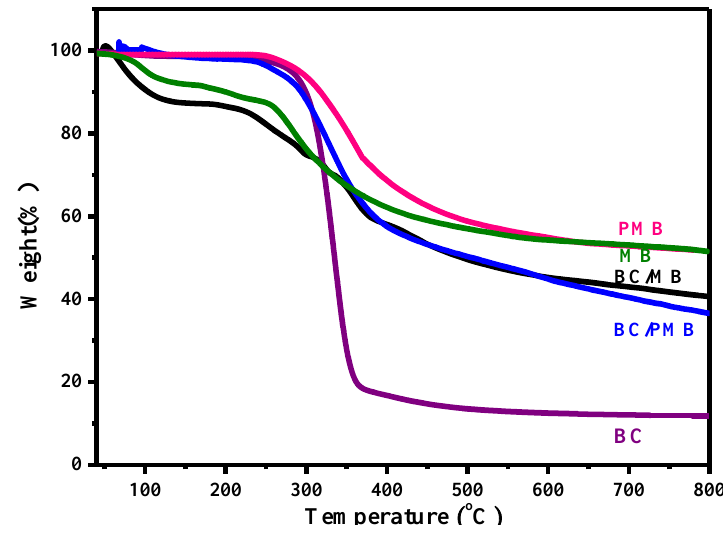
Figure 3. TG curves of the PMB, MB, BC, BC/MB and BC/PMB.